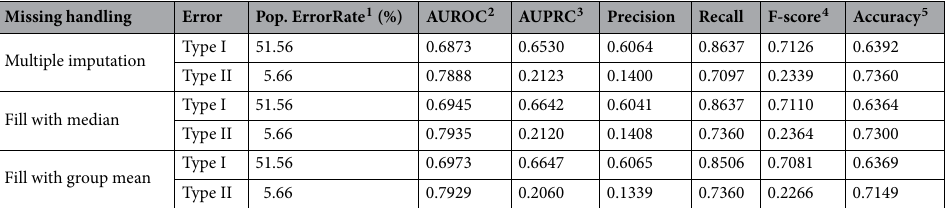
Missing handling